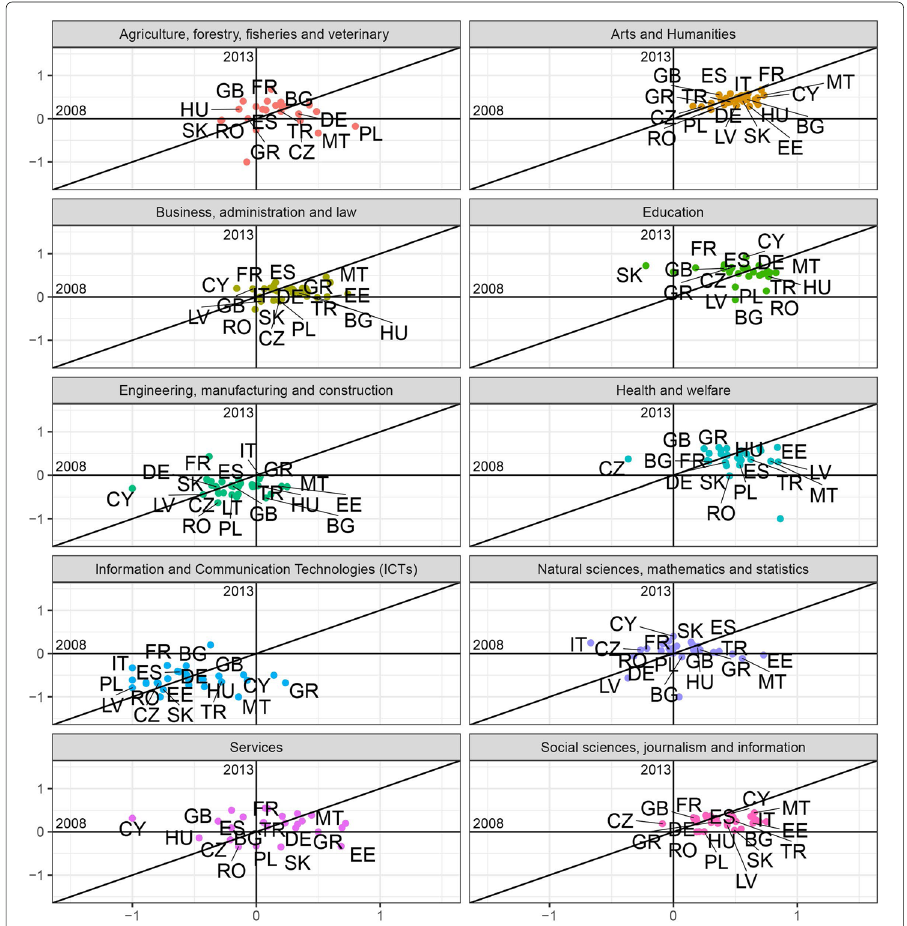
Fig. 3 Gender balance in the incoming flows across fields of study for the year 2008 against 2013. The scatter plots show the F / M B measure for the incoming flows of students for the years 2008 and 2013 for ten fields of study corresponding to the ISCED-F 2013 classification. Two macro fields ( Notknownorunspecified and Genericprogramsandqualifications ) are not showed. The label of the following countries are not displayed to improve readability: Austria (AT), Belgium (BE), Croatia (HR), Denmark (DK), Finland (FI), Iceland (IS), Ireland (IE), Liechtenstein (LI), Luxembourg (LU), Norway (NO), Portugal (PT), Slovenia (SI), Sweden (SE), Switzerland (CH), The Netherlands (NL). Note that the axes have the same scale limits, although the visual projection could appear